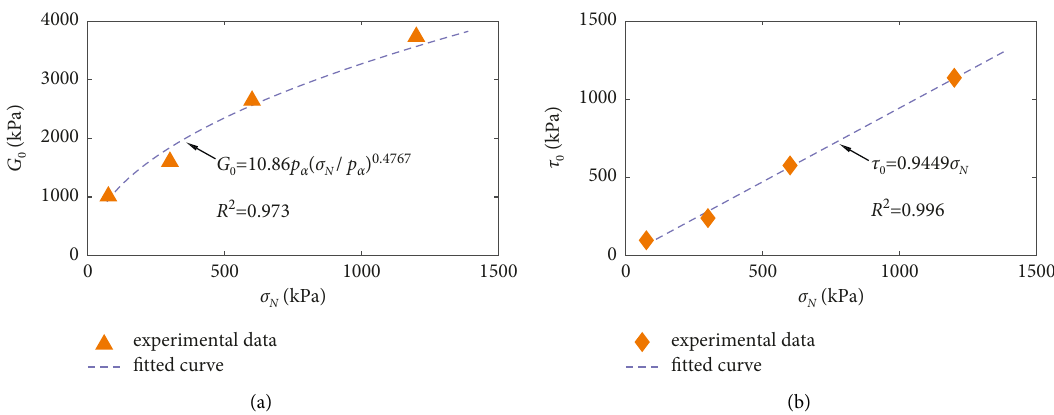
Figure 3: Variations of (a) G 2 representing the reference pressure and the coefficient of determination, 0 and (b) τ 0 with σ N . ( p a and R respectively).